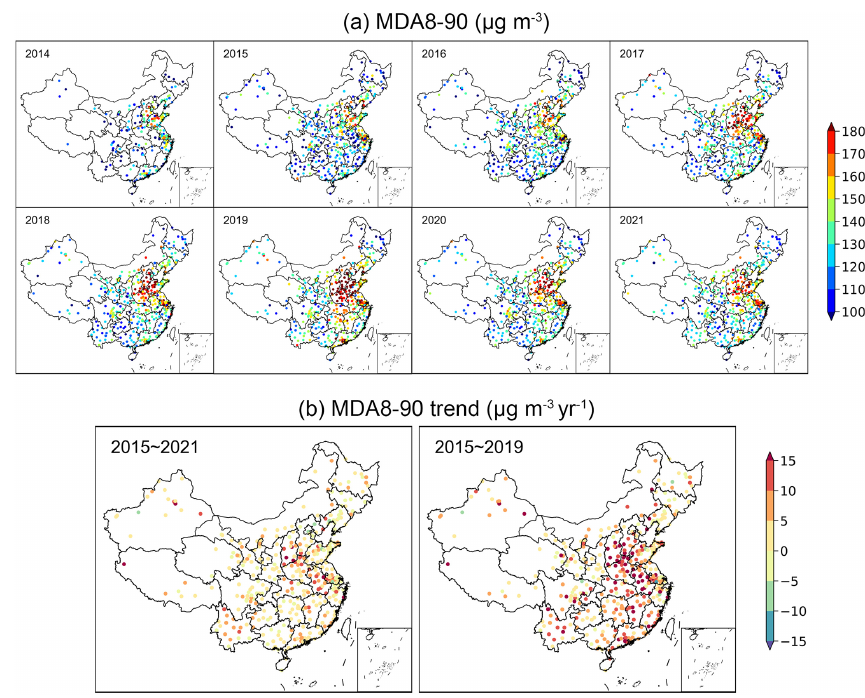
Figure 2. Spatiotemporal distributions of MDA8-90th ozone in the study area from 2014 to 2021 and trends for 2015–2019 and